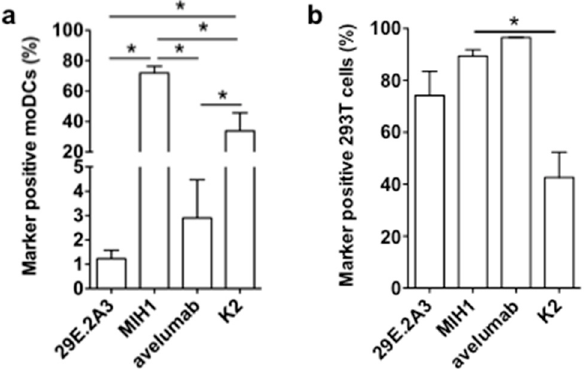
Figure 4. Binding of anti-PD-L1 mAbs and sdAb K2 on PD-L1 pos moDCs versus 293T cells. Graph summarizing the percentage PD-L1 pos moDCs ( a ) or 293T cells ( b ) detected in flow cytometry upon staining with the mAbs 29E.2A3, MIH1 or avelumab, or sdAb K2. Cells stained with isotype matched control mAbs or sdAb R3B23 served as a control. The graphs summarize the results of three independent experiments. The number of asterisks in the figures indicates the statistical significance as follows: * p < 0.05; ** p < 0.01 and *** p < 0.001.